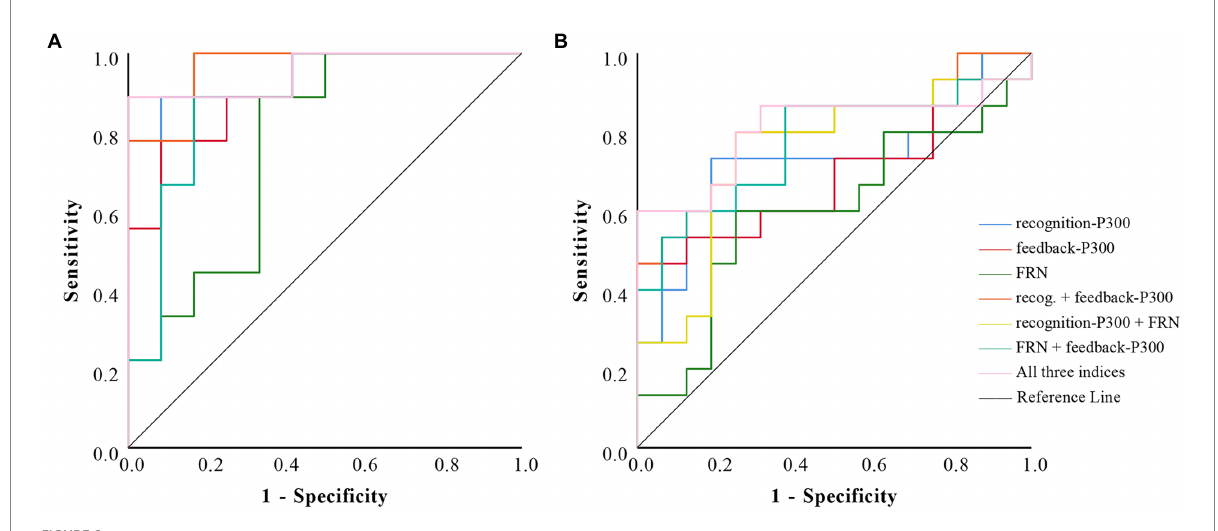
FIGURE 6 Receiver operating characteristic (ROC) curves of different ERP component indices in the high belief group (A) and low belief group (B)